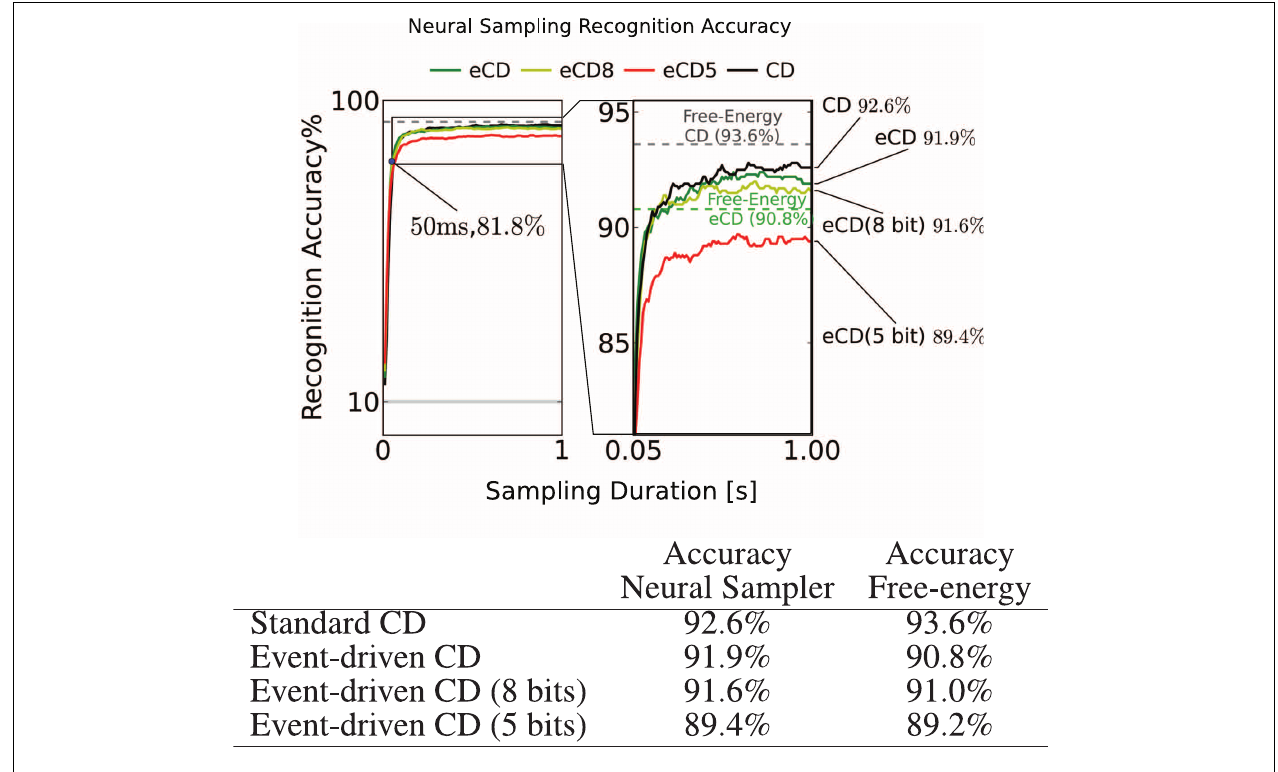
FIGURE 8 | To test recognition accuracy, the trained RBMs are sampled using the I&F neuron-based sampler for up to 1s. The classification is read out by identifying the group of class label neurons that had the highest activity. This experiment is run for RBM parameter sets obtained by standard CD (black, CD) and event-driven CD (green, eCD). To test for robustness to finite precision weights, the RBM was run with parameters obtained by